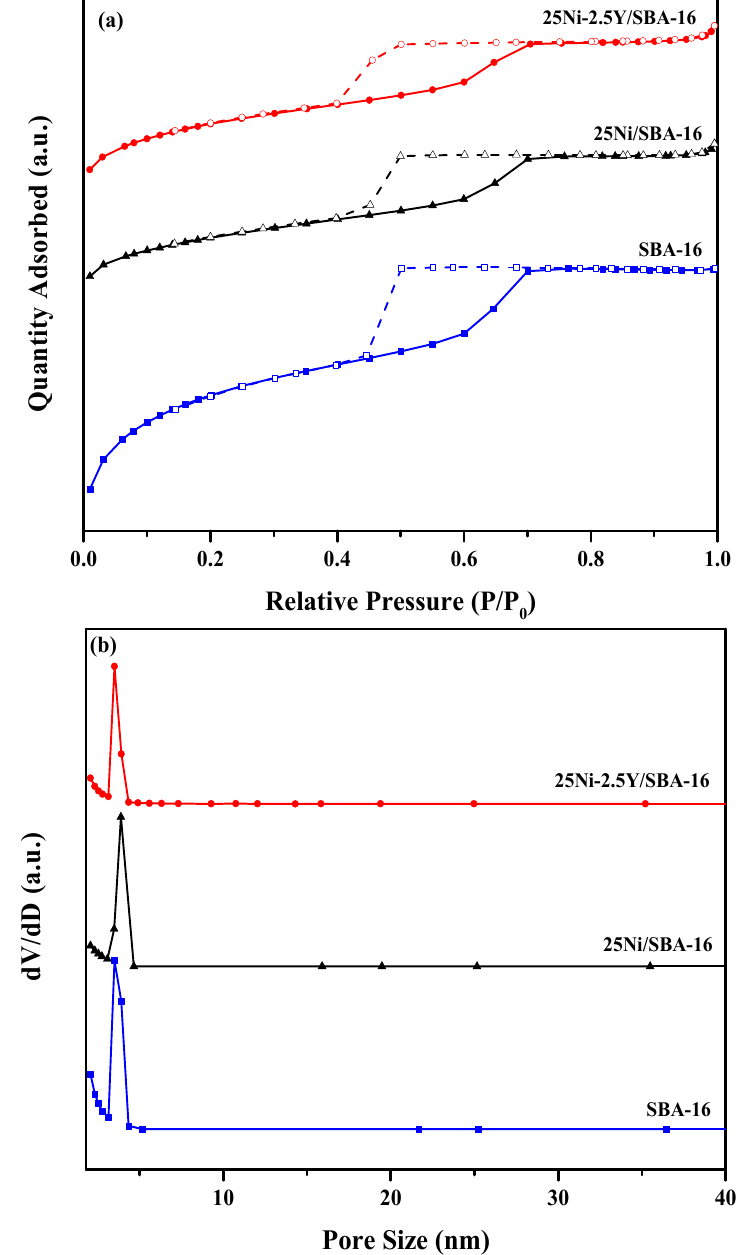
Figure 3. ( a ) N 2 adsorption/desorption isotherms and ( b ) Pore size distribution of: SBA ‐ 16, 25Ni/SBA ‐ 16 and 25Ni ‐ 2.5Y/SBA ‐ 16.